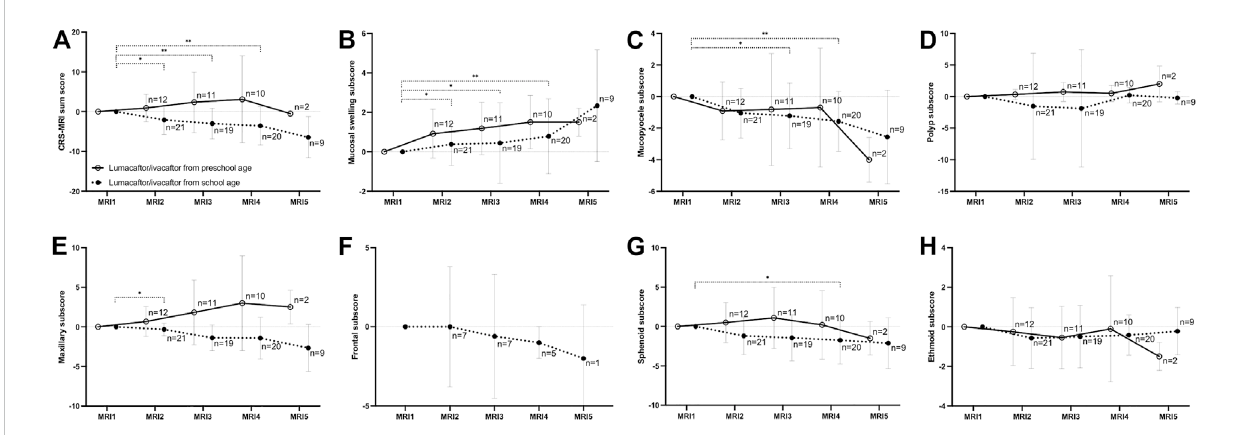
FIGURE 3 Changesofthechronicrhinosinusitismagneticresonanceimaging(CRS-MRI)sumscoreandsubscoresfrombaseline(MRI1)aftertherapystartwith lumacaftor/ivacaftor (MRI2-5) in children with cystic fi brosis. The CRS-MRI sum score (A) , abnormality subscores (B – D) and sinus subscores (E – H) were grouped by MRI timepoints. The mean is indicated by a circle and whiskers mark the standard deviation. * p < 0.05 vs. MRI1, ** p < 0.01 vs.